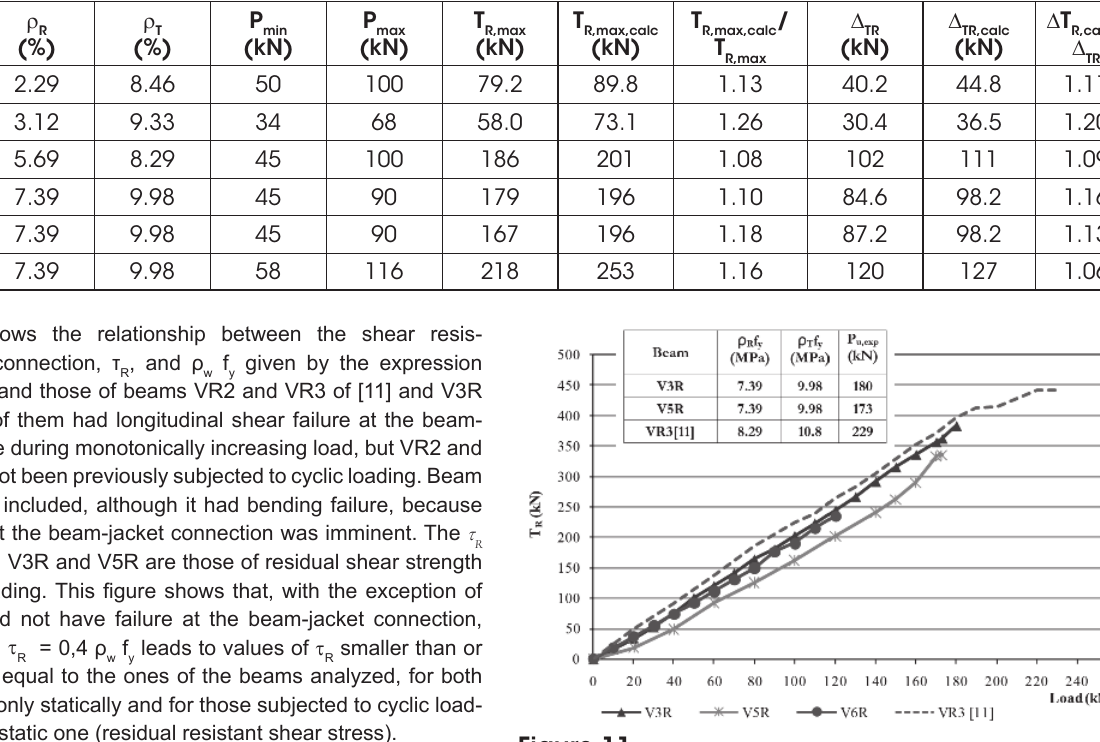
and force variation D T under cyclic loading, obtained from R,max R